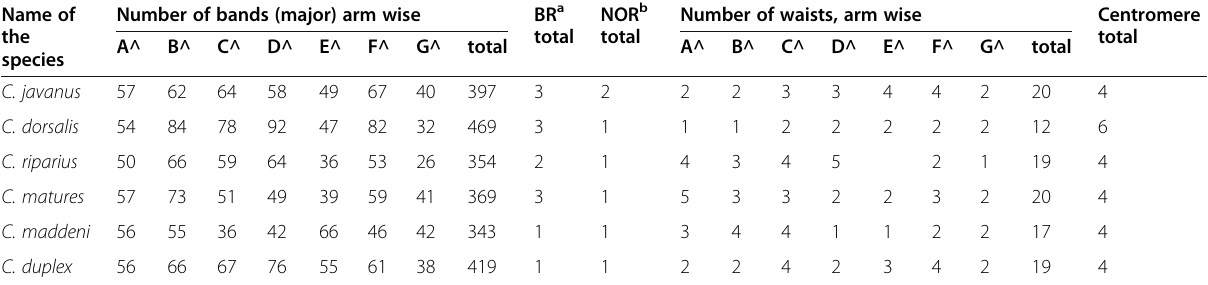
Table 1 Polytene chromosome features in different species of Chironomus (Figs. 2, 3, 4, 5, 6, 7, and 8) Name of Number of bands (major) arm the species